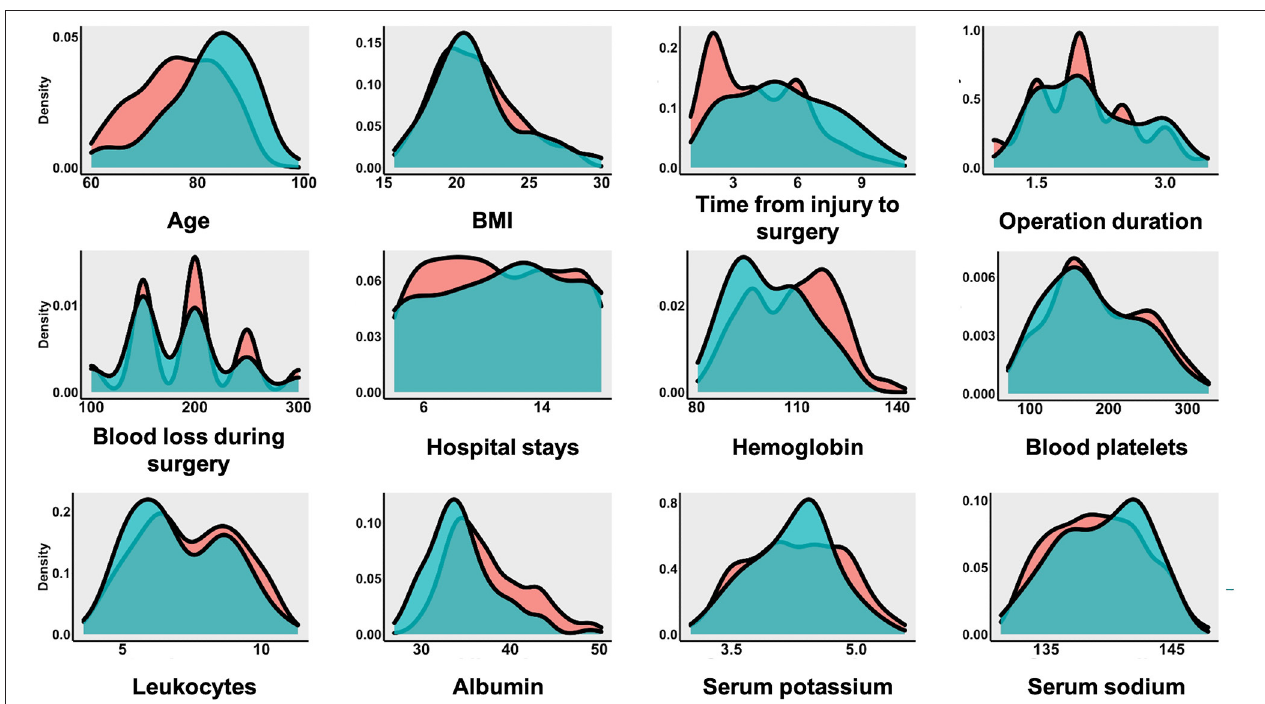
FIGURE 2 | The continuous variables distribution of live group and dead